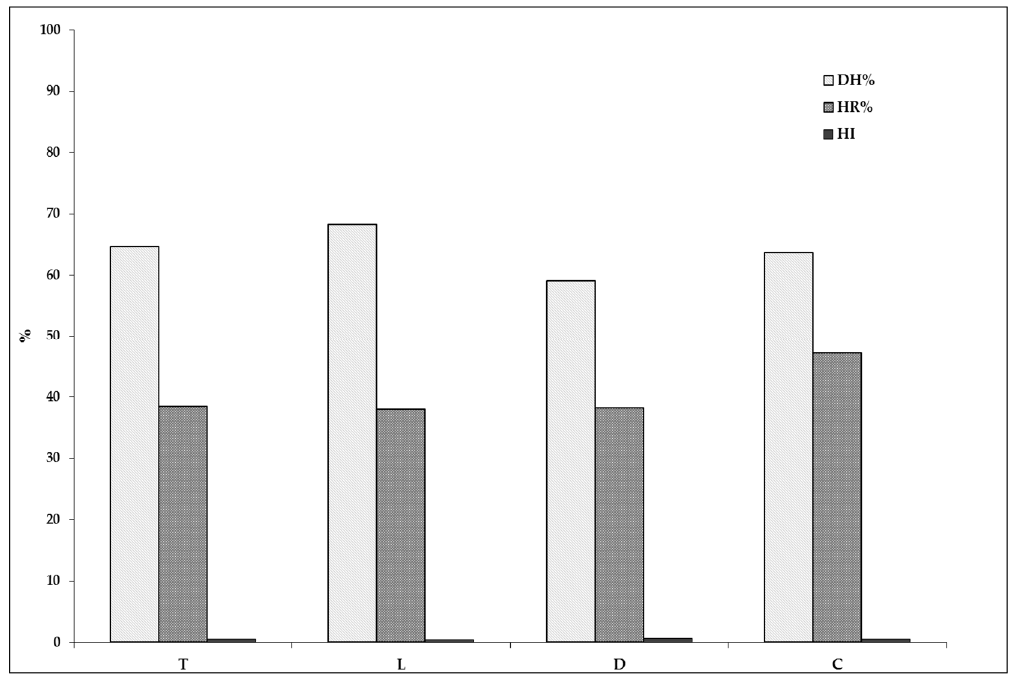
Figure 1. DH%, humification degree; HR%, humification rate; HI, humification index.